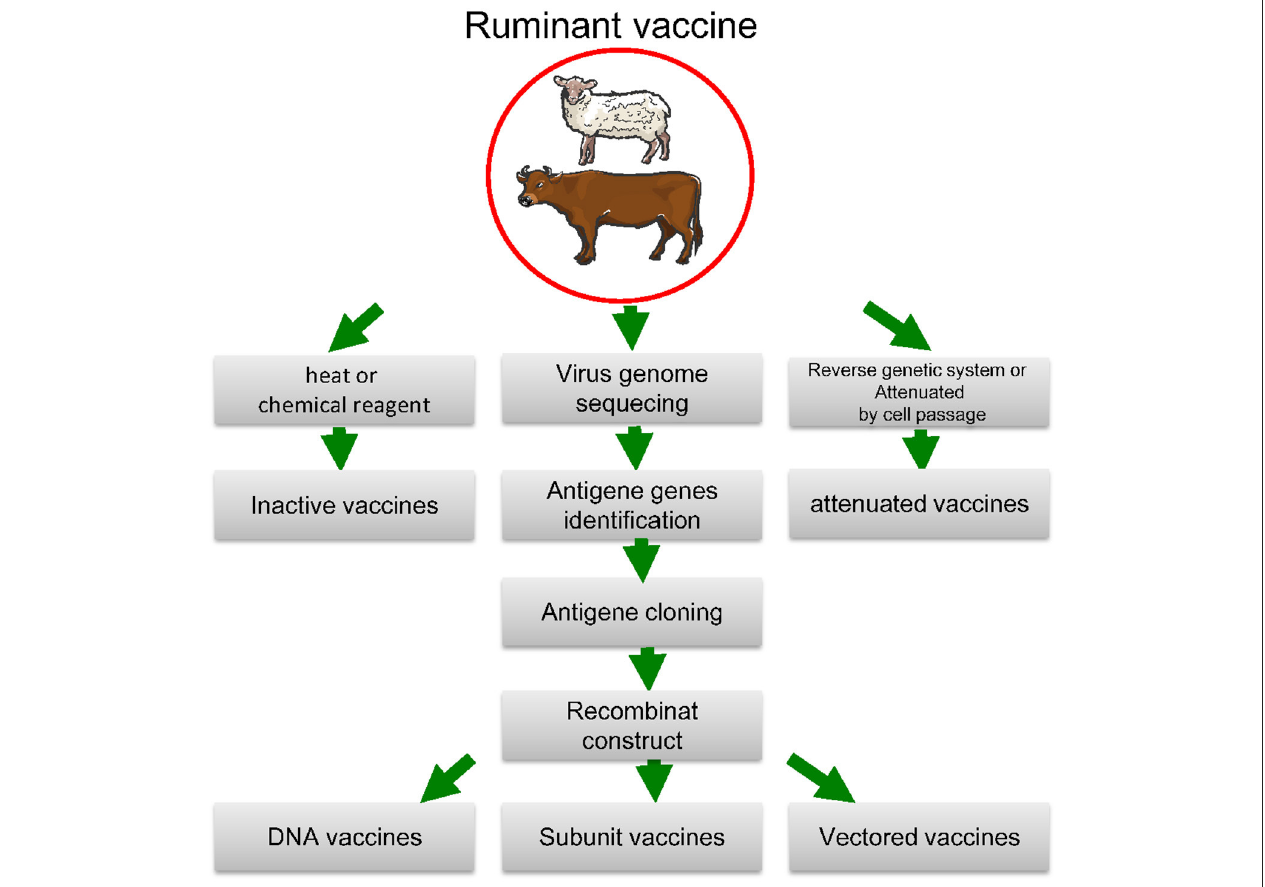
FIGURE 2 | Biotechnological approaches to vaccine development. The antigen-coding gene is isolated and either expressed and extracted from a protein-production device or directly expressed by the vaccine receiver after injecting an engineered plasmid or a live vector. To extend the immune response, prime-boost techniques use a variety of antigen distribution mechanisms. The method with reverse genetics Attenuated vaccines are made with cell passage, whereas inactive vaccines are made with heat or chemical